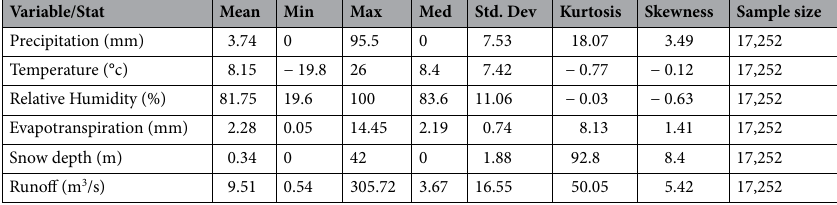
Table 2. The statistical characteristics of the applied data.